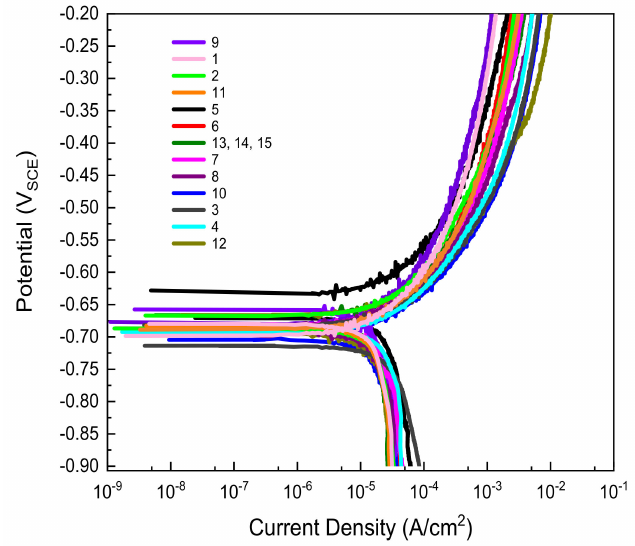
Figure 3. Potentiodynamic polarization curves of carbon steel with variations in pH, chloride, and sulfate concentrations based on an experimental design of RSM with BBD. Table 4. Experimental observations and predicted data for response variables obtained from the